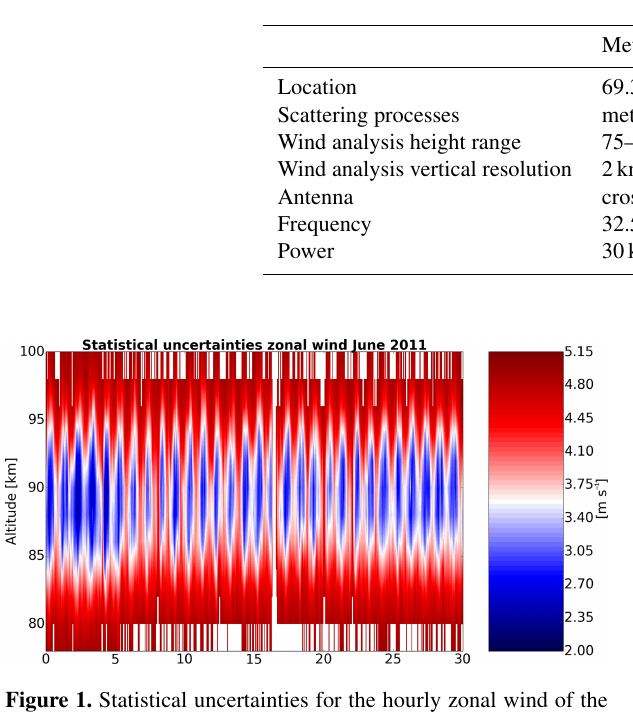
Table 1. Technical data and main parameters for the radars used in this study.